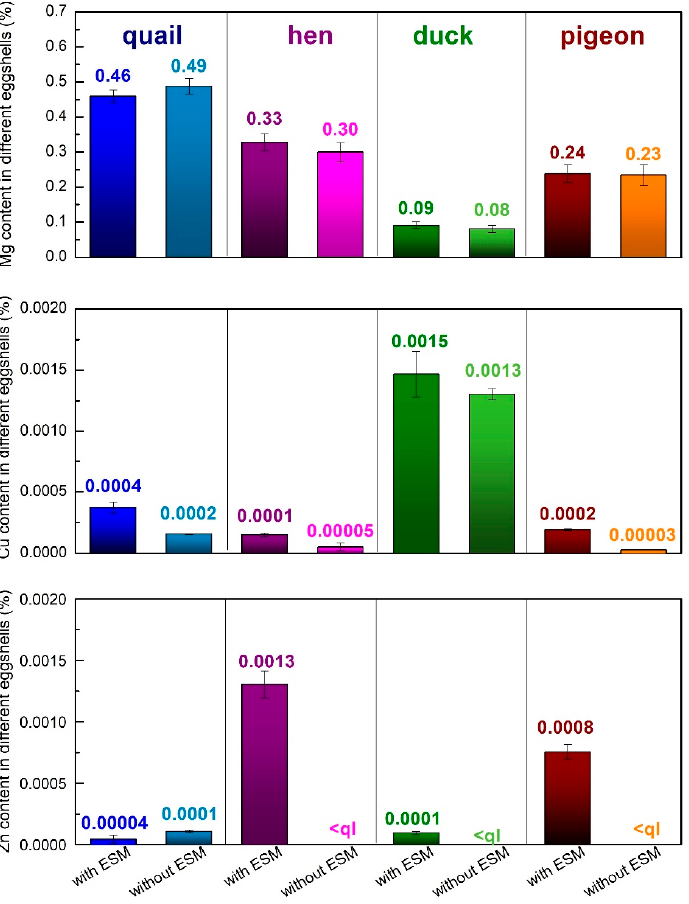
Figure 3. Magnesium, copper, and zinc contents ( w / w %) in various poultry species eggshells determined with the ICP-OES (magnesium) and ICP-MS (Copper and zinc measurements (<ql indicates below the quantification limit; for Zn, ql = 4.94·10 − 6 %). Significant changes in the composition were observed during other metals ion content analyses (Figure 3). The largest magnesium content was found in the eggshells of quail (about 0.5%) and only a tiny amount, less than 0.1%, of this element was detected in the duck eggshells. It is also worth mentioning that only in the quail eggshell the magnesium amount increased after the eggshell membrane removal. In other eggshells, a small decrease of magnesium content was observed after peeling off the ESM. Trace amounts of copper and zinc were also detected. The duck eggshells contained the highest amount of copper while the hen eggshells contained a larger amount of zinc in comparison to the other samples. All the analyzed samples showed the tendency toward a decrease in both metal ions after the EMS removal which indicates that the presence of those metals is strongly related to the organic part of the eggshell. The SEM images in Figure 4 show that the crystal morphology and size the obtained calcium phosphate materials depend on the eggshells type. The material obtained from the quail eggshells was composed of thin and short rod-shaped crystals as well as small hexagonal flakes of a few nanometers in size (Figure 4a). In the case of the products derived from the hen eggshells, needle-like aggregates were observed (Figure 4b). Moreover, the small hexagonal flakes emerged. The use of duck and pigeon eggshells as a calcium biosource resulted in more diverse structures (Figure 4c,d). All these samples